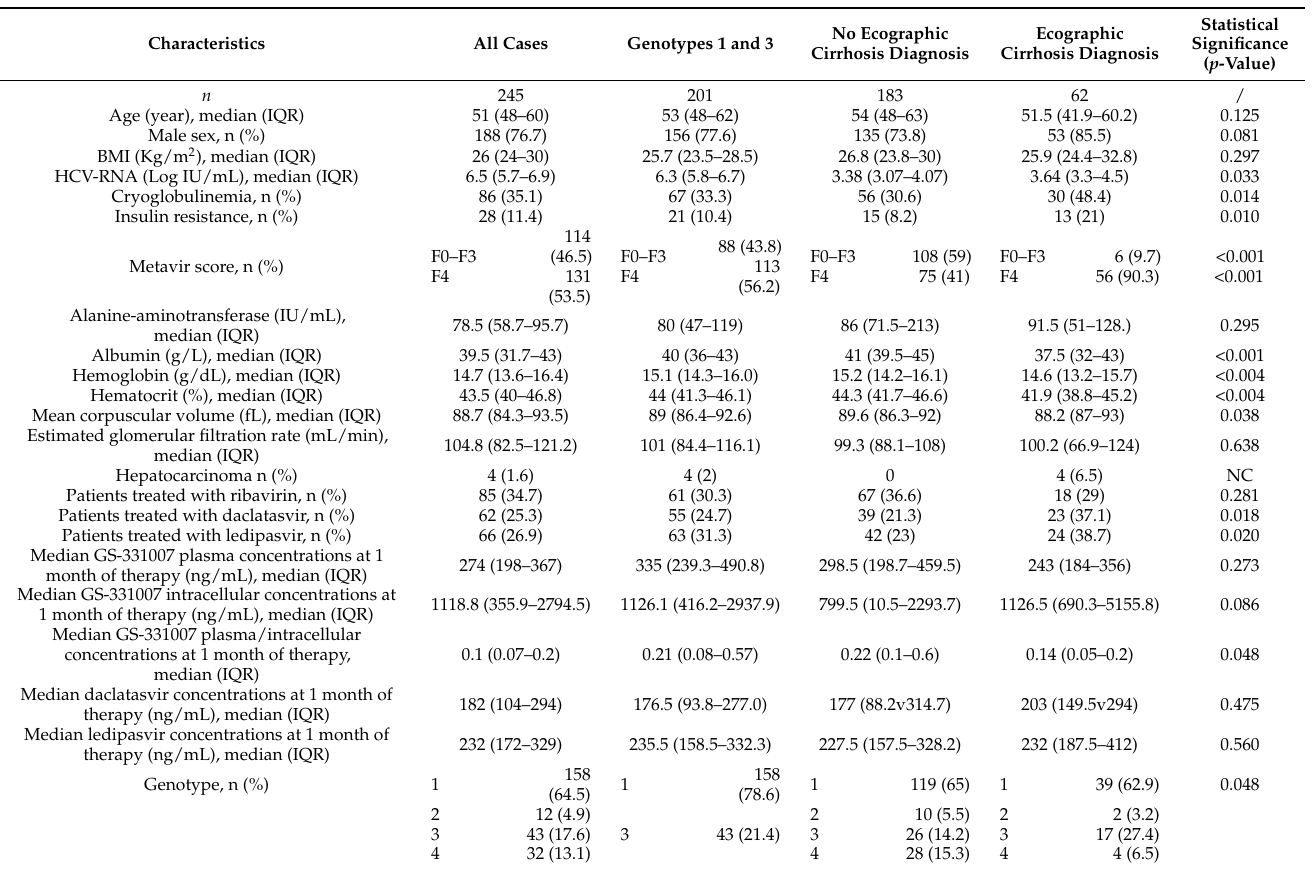
Table 1. Patients’ characteristics at baseline. Differences between cirrhotic and non-cirrhotic patients are reported with p